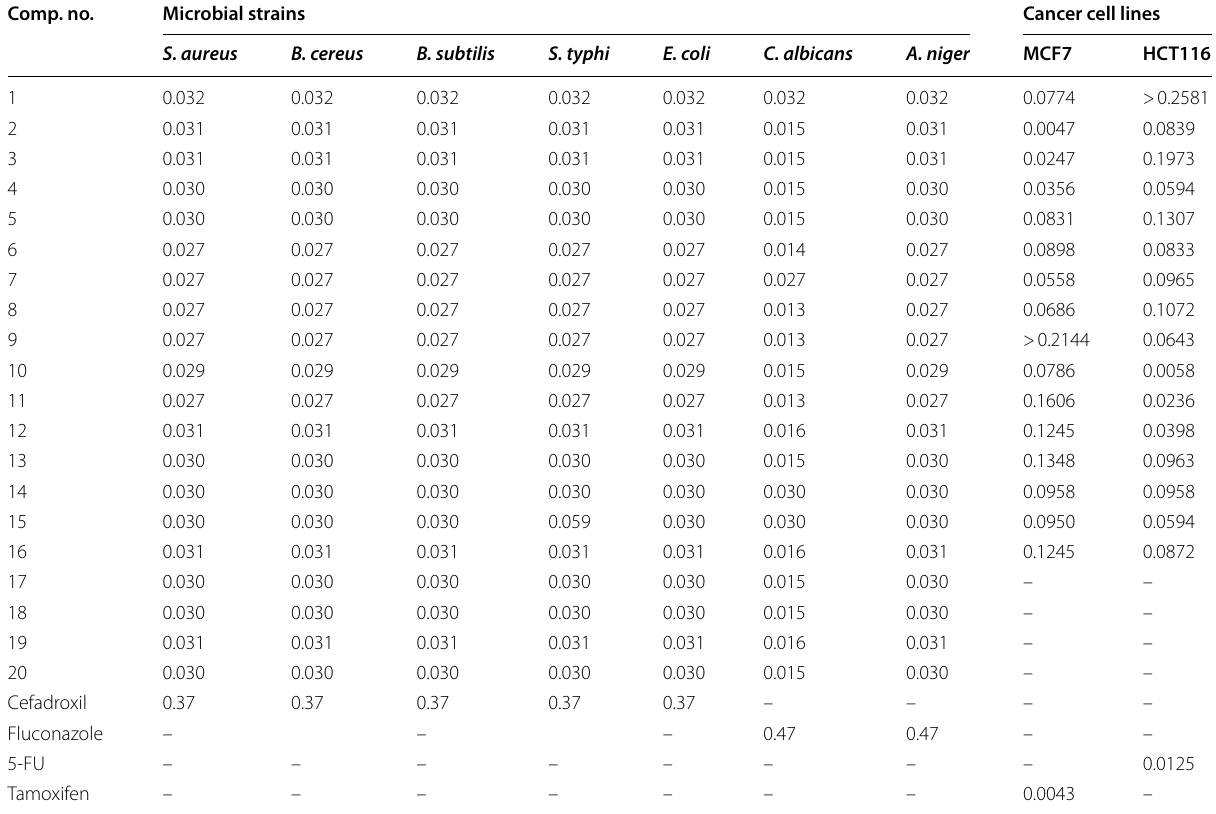
Table 1 Antimicrobial (MIC zole-2-ylthio)-2-ylthio)- N -substituted acetamides Comp.